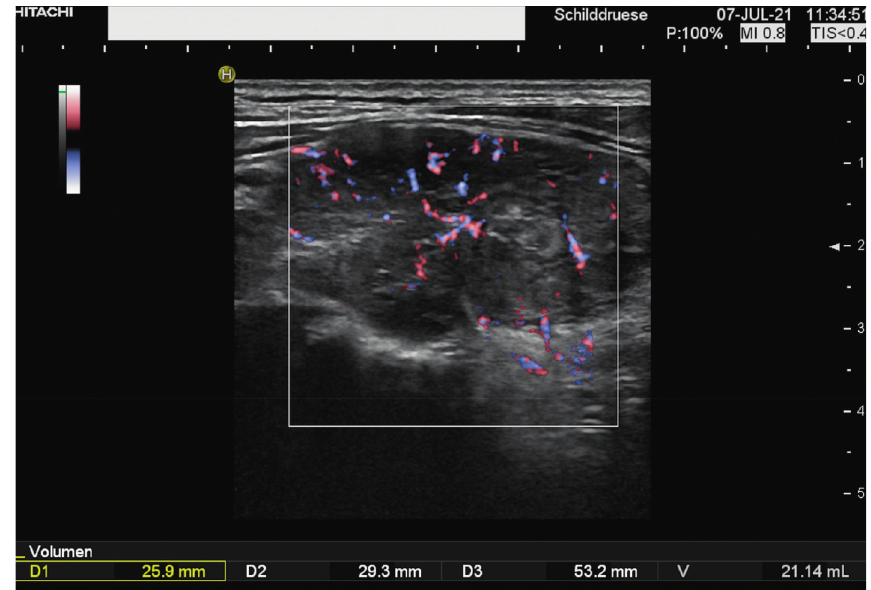
Figure 2: The right lobe of the thyroid gland with a hypoechogenic texture and a diffusely hypoperfused